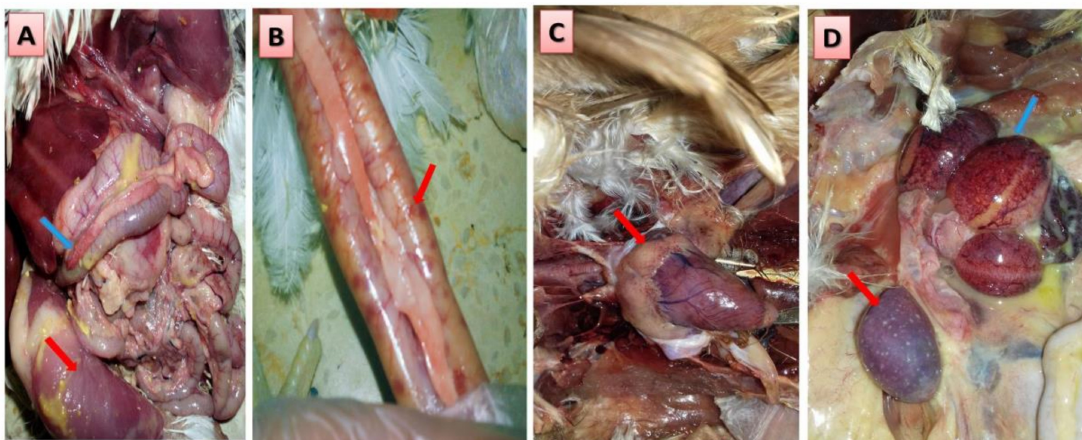
Figure 2. Post mortem changes of H5 AIV in tested chickens. ( A ) Congested muscles (Red arrow) and hemorrhagic pancreas (blue arrow). ( B ) Hemorrhages in intestinal tract. ( C ) Hemorrhages in coronary fat. ( D ) Enlarged, congested, and mottled spleen (red arrow) and hemorrhagic ovarian follicles (blue